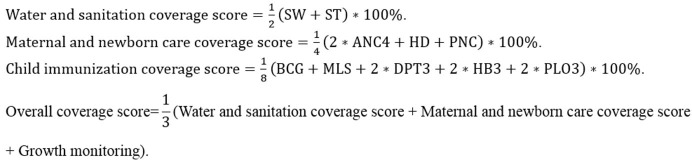
Formulas for building composite coverage scores for essential interventions along the MNCH care continuum. SW, Improved drinking water sources; ST, Improved sanitation facilities; ANC4, At least four antenatal care sessions; HD, Hospital delivery; PNC, At least one postnatal care session; BCG, BCG vaccination; MSL, Measles vaccination; DPT3, DPT vaccination (3 doses); HB3, Hepatitis B vaccination (3 doses); PLO3, Polio vaccination (3 doses). The child immunization coverage score was only available for 2008 and 2013 and was thus not calculated in the overall coverage score.